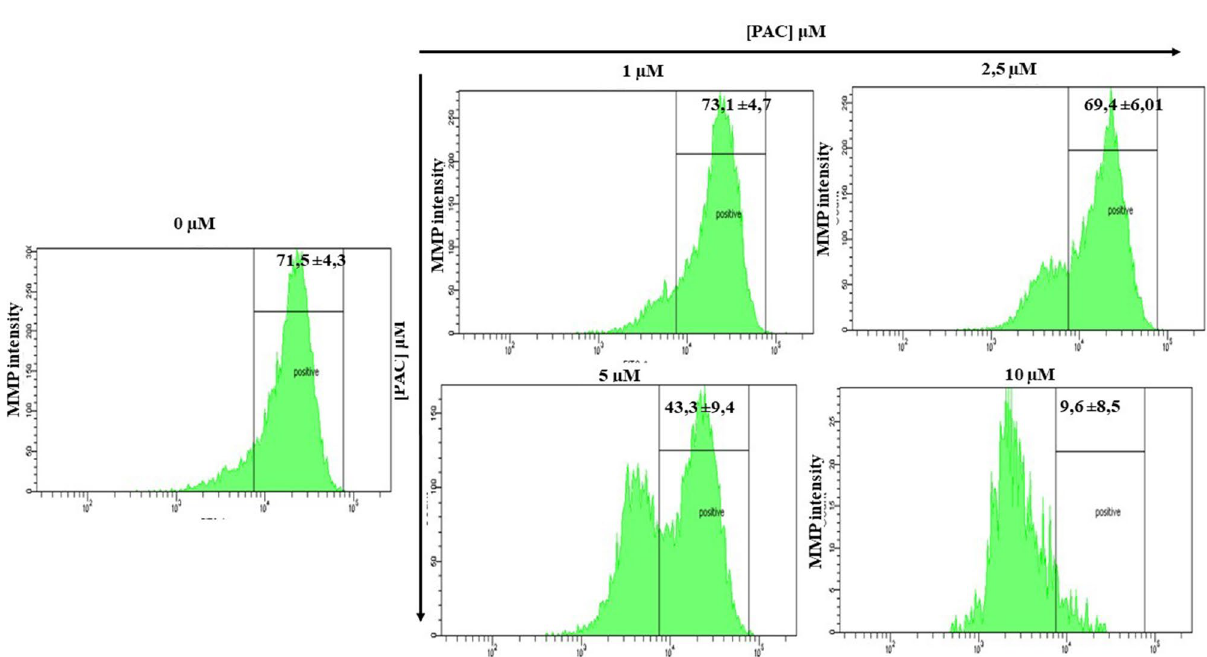
Figure 9. PAC- treatment reduces mitochondrial membrane potential (MMP) in oral cancer cells. The MMP expression was measured by the MitoProbe DiOC 2 (3) Assay Kit for Flow Cytometry (n =